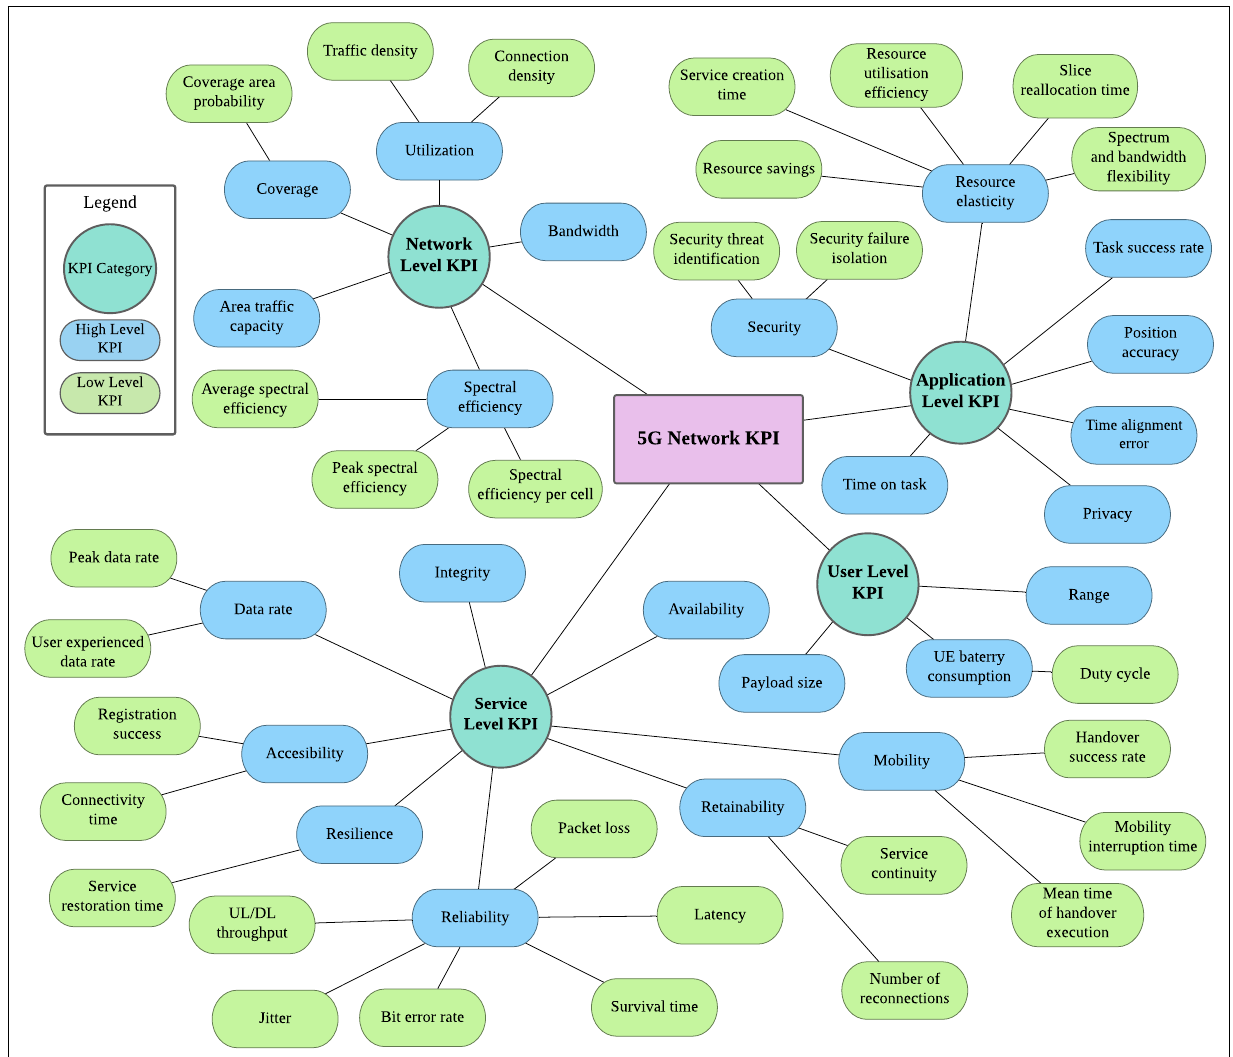
Figure 2. Taxonomy of 5G network